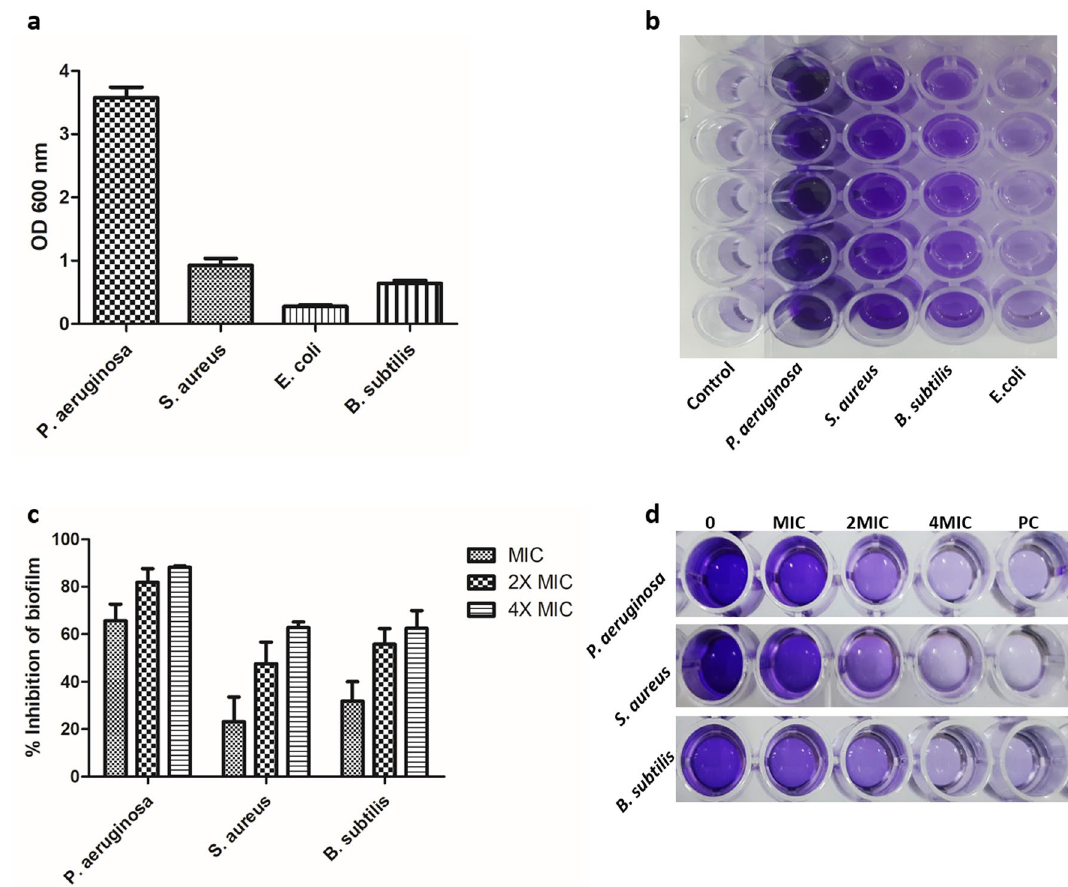
Figure 3. ( a ) Biofilm biomass assessment by crystal violet staining (OD 600 nm) of four bacterial strains P. aeruginosa , S. aureus , E. coli , and B. subtilis after 48 h in Brain Heart Infusion broth (BHIB) supplemented with 2% glucose. ( b ) The 96-well microtiter plate assay showed biofilm formation by four bacterial strains. ( c ) Antibiofilm efficacy of ethyl acetate crud extract from Paecilomyces sp. (AUMC 15510) on P. aeruginosa , S. aureus , and B. subtilis as assessed by crystal violet quantification of biofilm. ( d ) The 96-well microtiter plate assay depicted the effect of ethyl acetate crud extract on the biofilm formation of P. aeruginosa , S. aureus , and B. subtilis . PC: Gentamicin (Positive Control). The error bars on the graph represent standard deviations as a percentage of biofilm